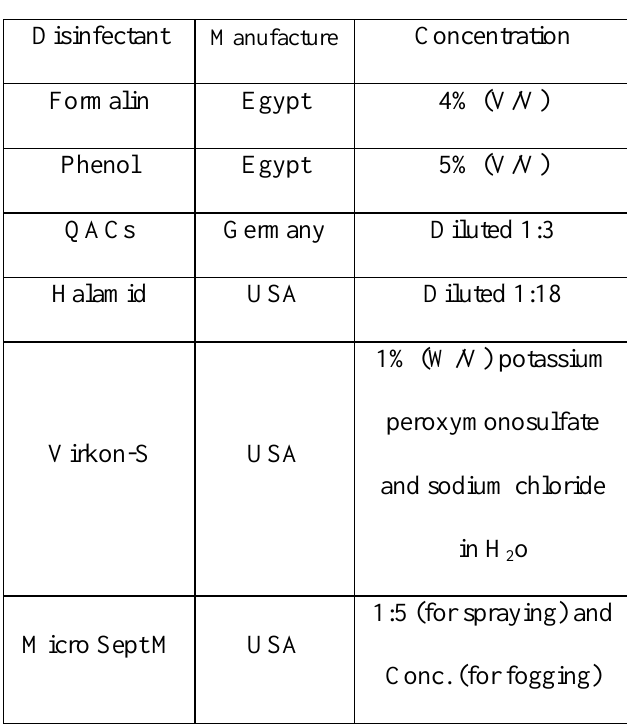
Table 1: Selected